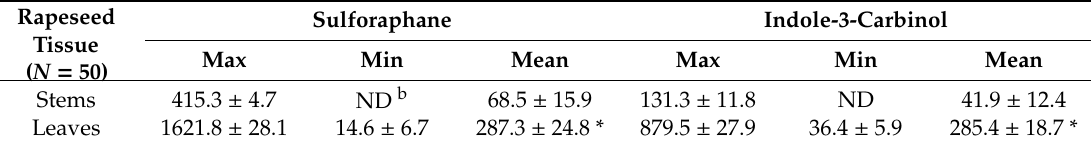
Table 4. Comparison of the extraction step and LOD with the previous methods. Matrix